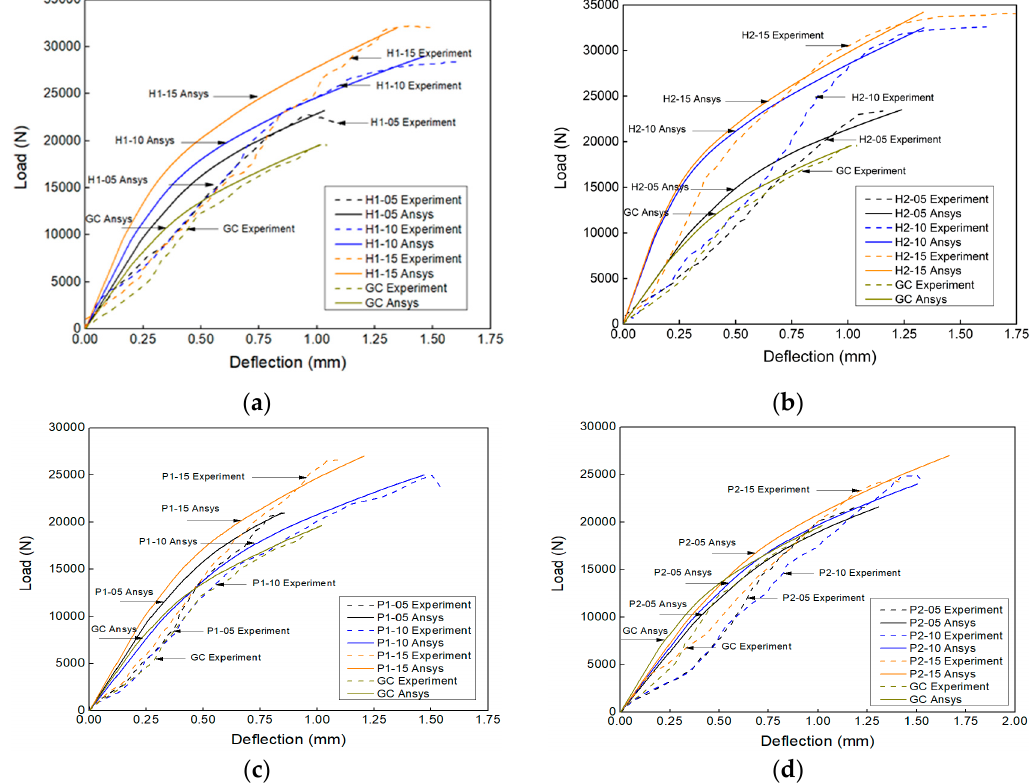
Figure 22. Comparison the load–deflection behavior. ( a ) Specimen H1; ( b ) specimen H2; ( c ) specimen P1; ( d ) specimen